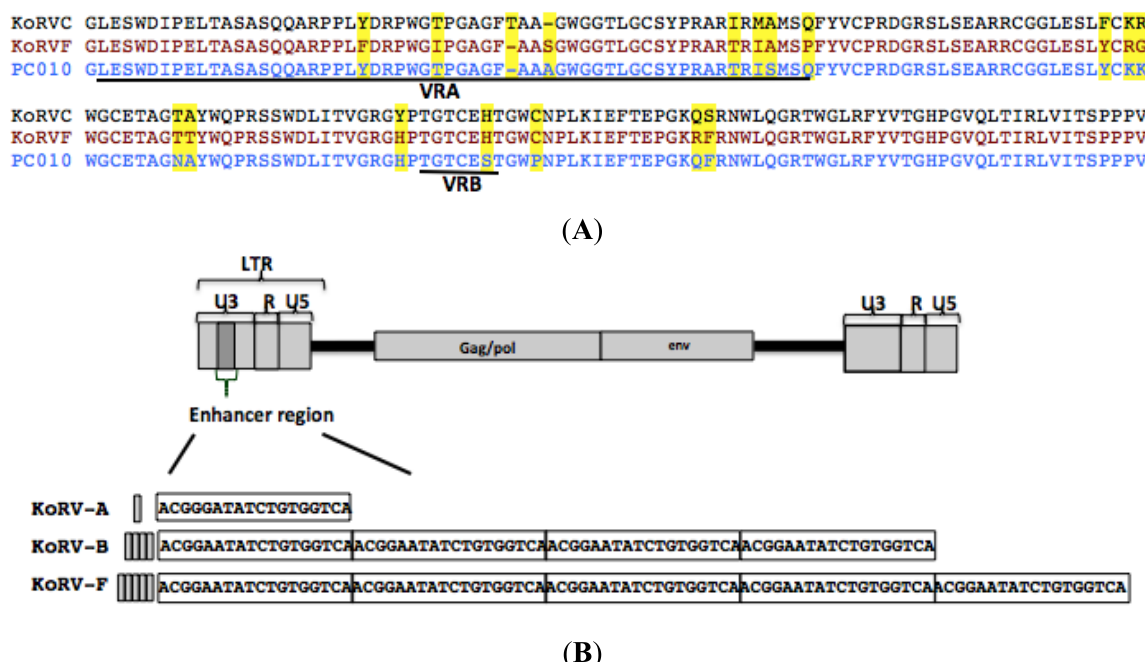
Figure 4. ( A ) The VRA region of KoRV-F is related to VRA regions of KoRV-C and PC010 KoRV envelope [16]. Envelope residues corresponding to KoRV-A envelope residue numbers 86–230 are aligned. VRA and VRB regions are underlined. Residues that differ among KoRV-E, F and PC010 are highlighted in yellow; ( B ) Schematic representation of the sites where the 18 nucleotide repeats are positioned within the U3 enhancer regions (dark grey) of KoRV-B and KoRV-F. The grey bar represents the tandem repeat of the 18-nucleotide insertion, with KoRV-A containing a single copy, KoRV-B four copies and KoRV-F five copies. The 18 nucleotides are